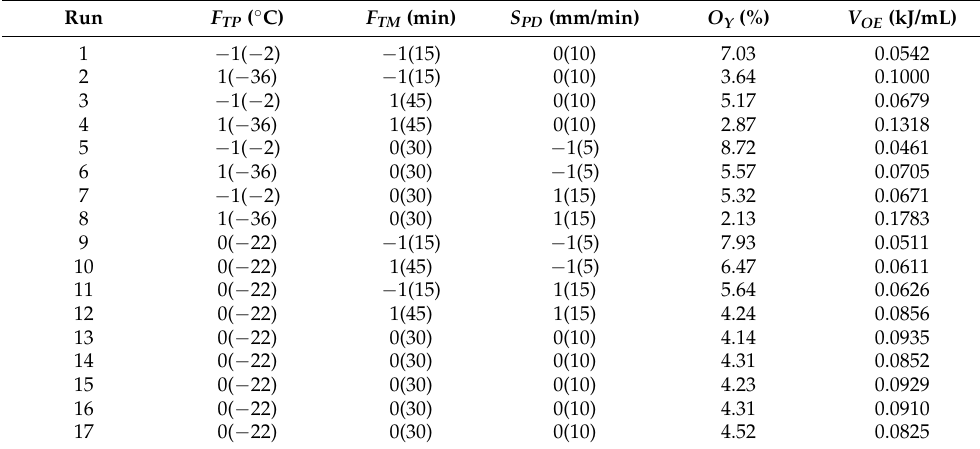
Table 5. Factor levels and calculated parameters under freezing